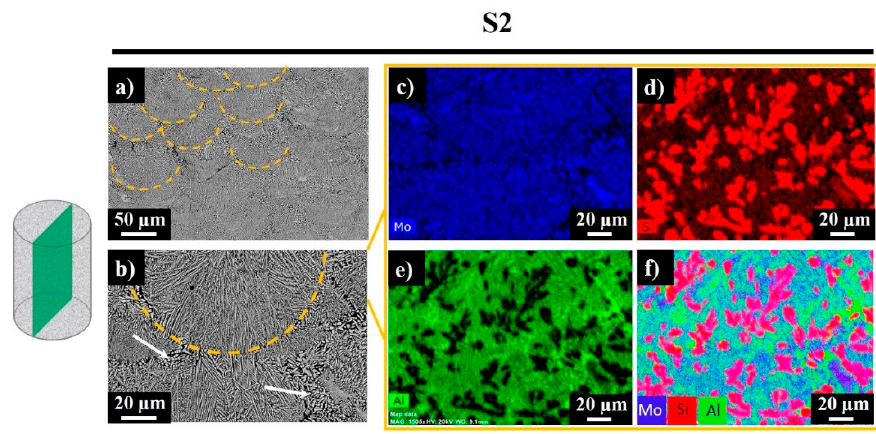
Figure 8. Top surface SEM images ( a , b ) and EDS mapping results for sample S2 ( c – f ).